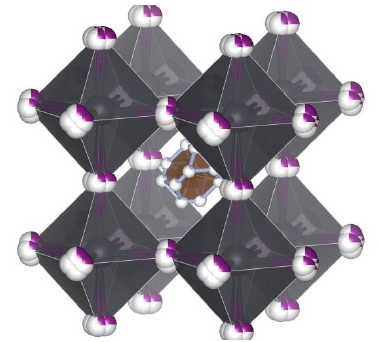
Figure 2. Schematic view of perovskite cubic structure and structural model of FAPbI 3 (FA cation located in the middle).